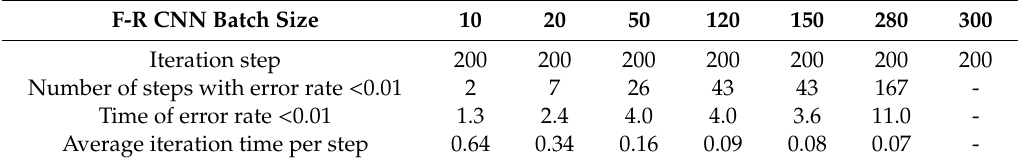
Time of error rate < 0.01 Average iteration time per